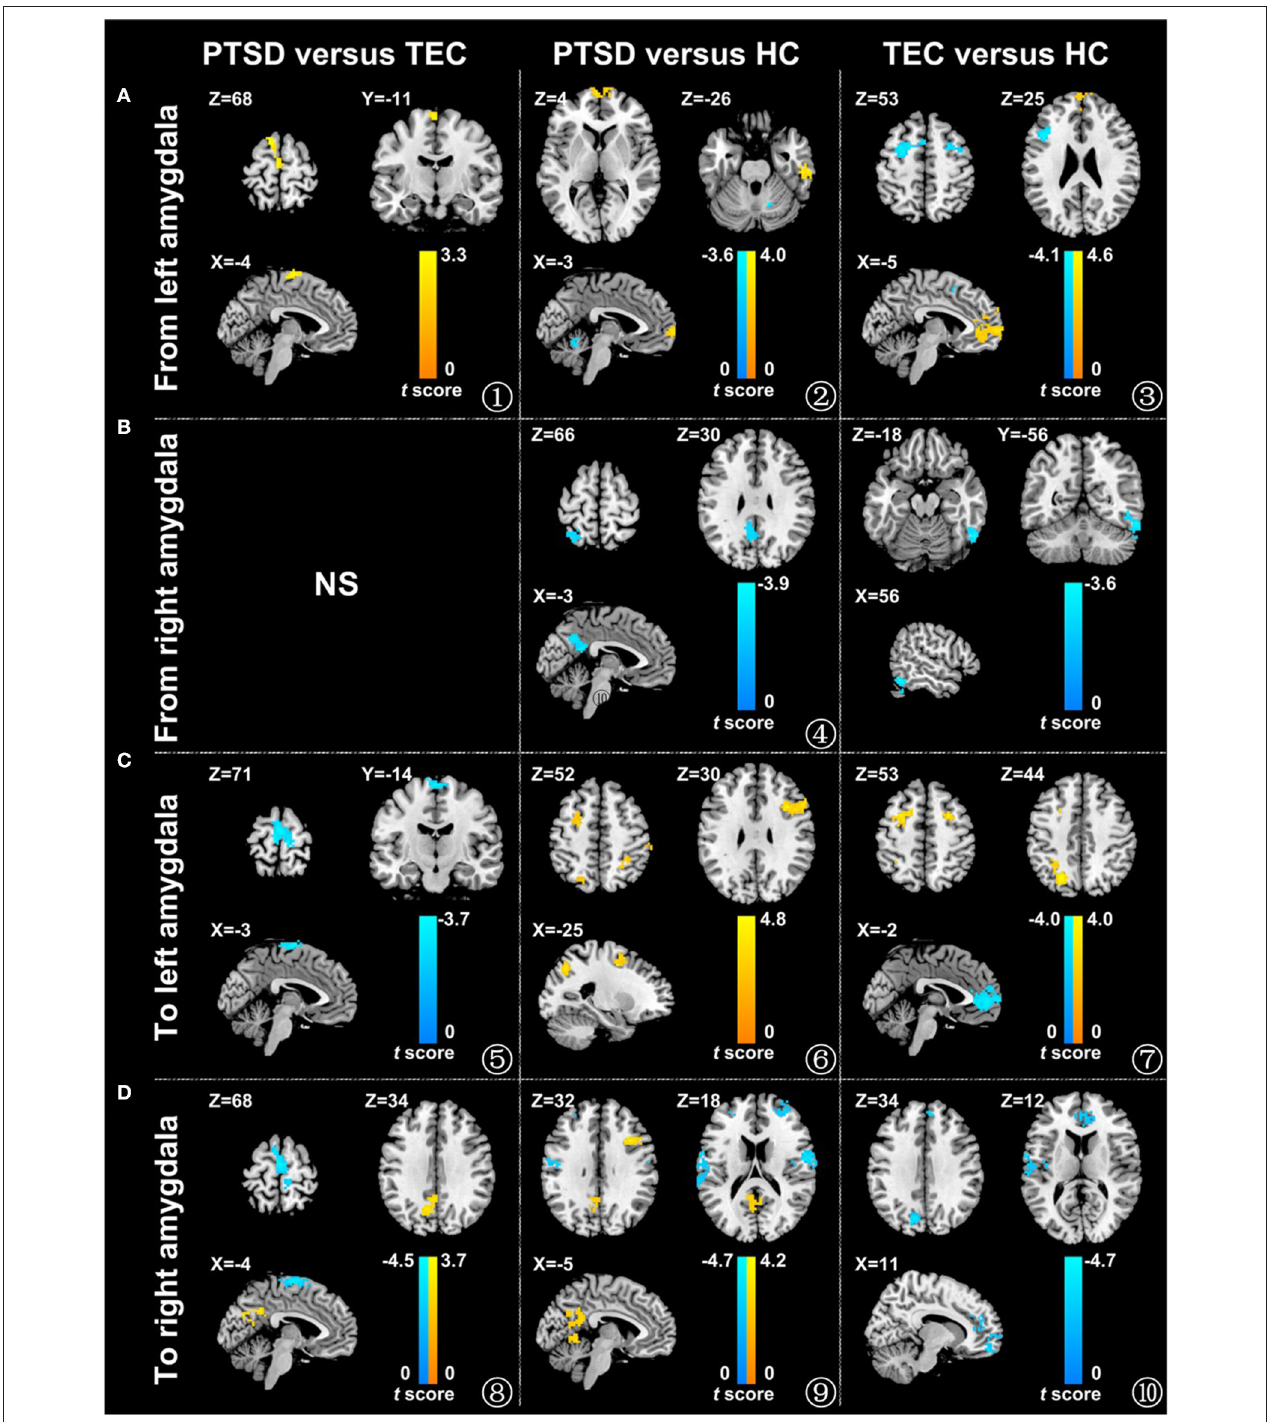
FIGURE 1 | Comparison of the effective connectivity between the amygdala and different brain areas in the different groups. The influence of the left amygdala on the whole brain (A) , the influence of the right amygdala on the whole brain (B) , the influence of the whole brain on the left amygdala (C) , and the influence of the whole brain on the right amygdala (D) ( P < 0.05, adjusted by AlphaSim). The warm color represents the positive functional connectivity; the cold color represents the negative functional connectivity. PTSD, post-traumatic stress disorder group; TEC, trauma-exposed control group; HC, healthy control group.